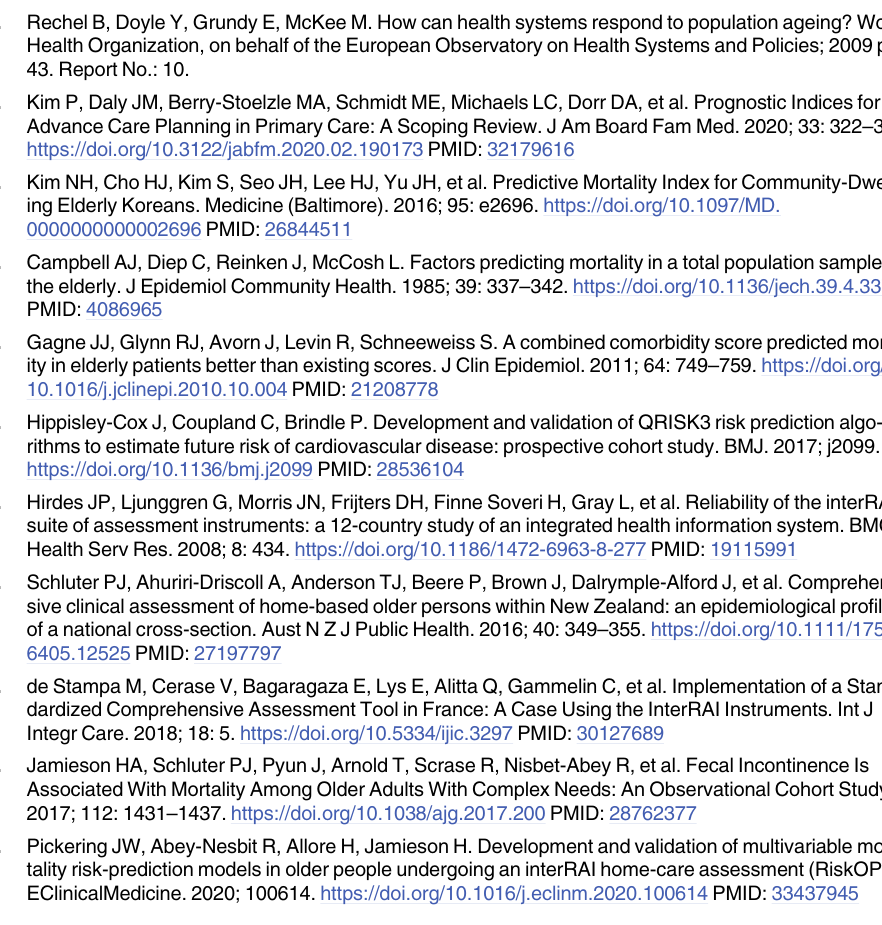
Fig 5. Calibration curves. Actual percentage of people with outcomes (and 95% CI) verse predicted percentage (and 95%CI) for all patients split into 10 groups. Perfect calibration is the dashed line. The new model (teal curve) has similar or better calibration than the baseline model (red curve). All patients are included in panel A. Panel B is for participants with Congestive Heart Failure, and Panel C for participants without Congestive Heart